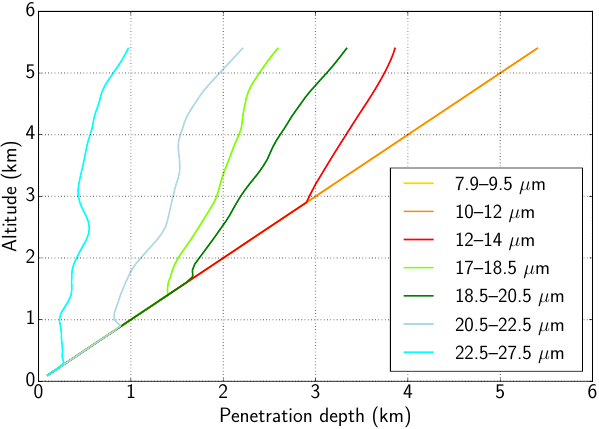
Figure 6. Penetration depth of each channel as a function of flying altitude for the 11 April flight. Penetration depth is defined as the downward distance from the plane such that the broadband trans- mittance in this channel reaches